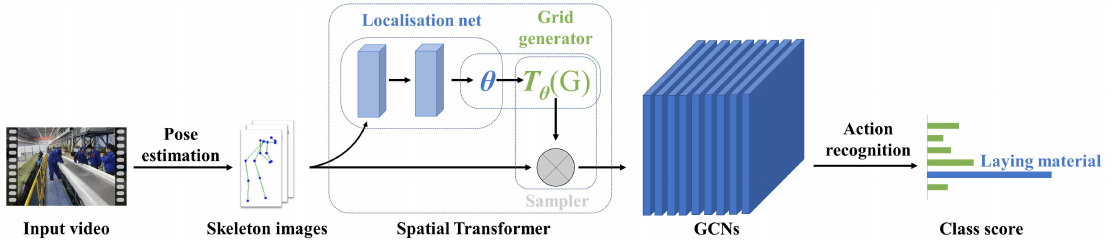
Figure 1. The overall framework for action recognition in industrial workflows. Graph convolutional network